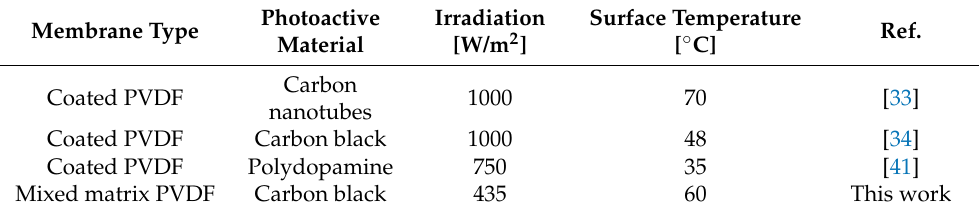
Table 3. Literature data of surface temperature of photoactive membranes.